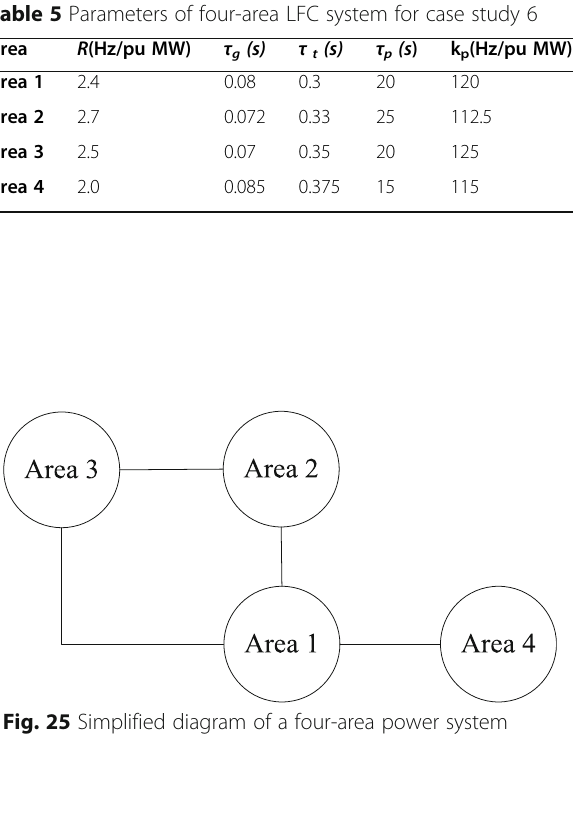
Table 6 Parameters of sliding mode controller based on GWO for FAPS